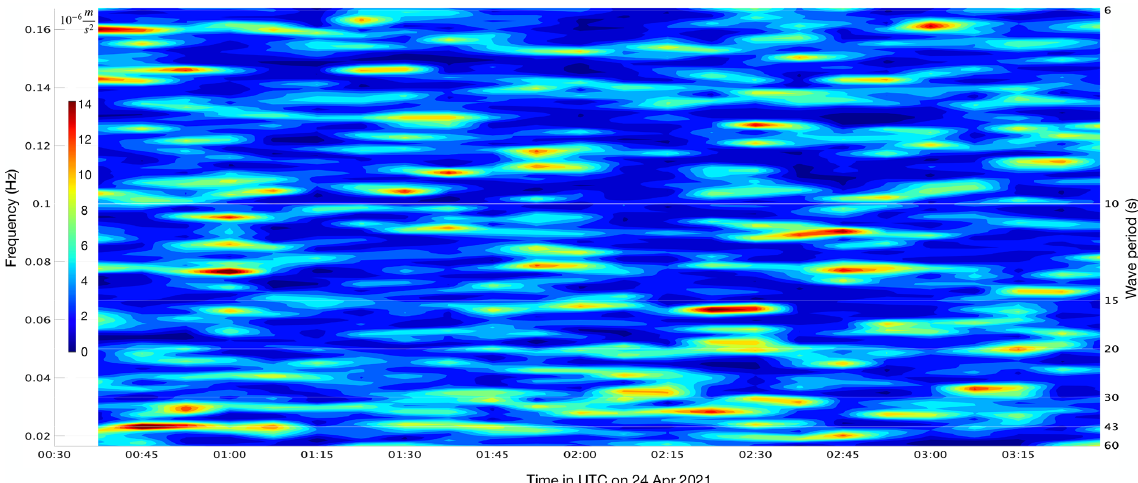
Figure 4. Example of vertical acceleration measured by IWR 33 during the first ∼ 3h after deployment on 24 April 2021. The acceleration is displayed as the power spectral density in the frequency–time domain as in a Welch periodogram. Numbers ranging from 6 to 60 to the right of the figure are period values in seconds corresponding with the frequency axis on the left-hand